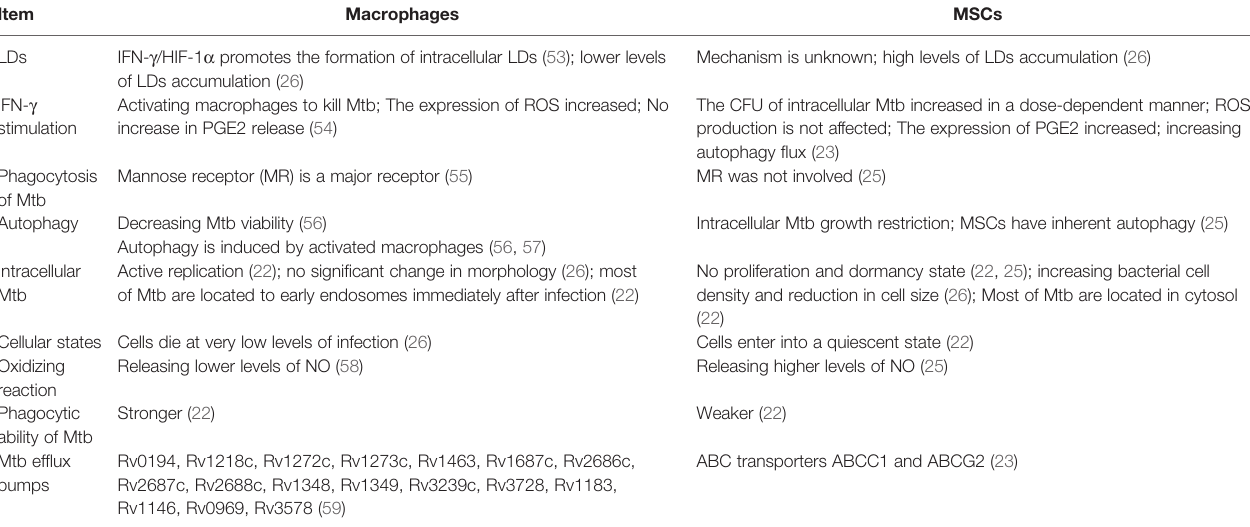
TABLE 1 | The differences between macrophages and MSCs after Mtb